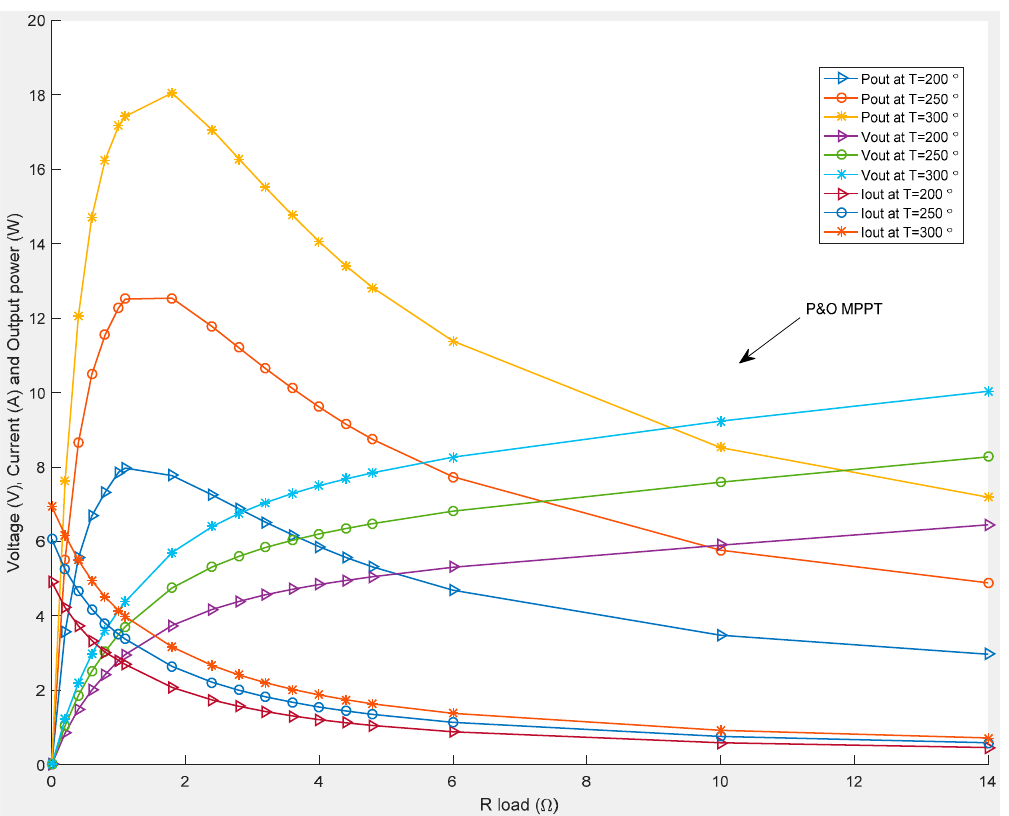
Figure 14. The output voltage, current and output power of P&O MPPT model for a single TEG.